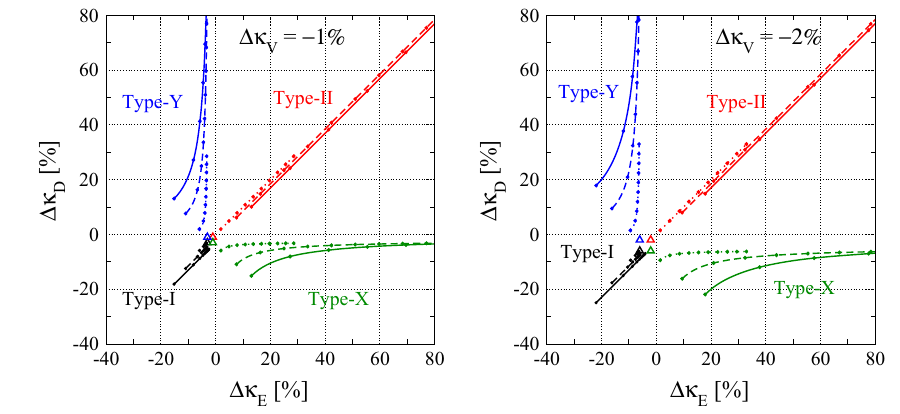
Fig. 3 Deviations in the Yukawa couplings on the (cid:18)κ the solid , dashed and dotted curves show the case for f = ∞ , 2200 ( E stands for E (1500)GeVand1780(1250)GeV,respectively,forthe left ( right ) panel . a charged lepton) and (cid:18)κ ( D stands for a down-type quark) plane D Each dot on the curve denotes the prediction with tan β = 1 − 10 with in the C2HDMs with s θ < 0. The left ( right ) panel shows the case = − 1 ( − 2 ) %. The black , red , green and blue curves show its interval of 1, and the dot at the left edge on each curve corresponds for (cid:18)κ V to tan β = 1. The triangles represent the prediction with θ = 0 the results in the Type-I, -II, -X and -Y C2HDM, respectively, while